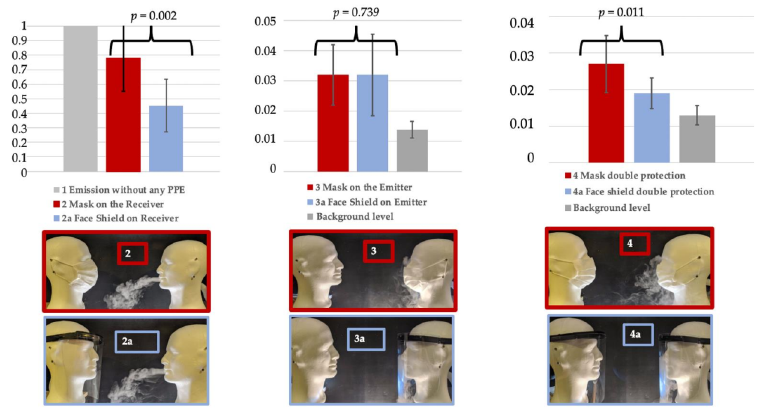
Figure 5. Reduction factors for the total particles: mask vs. face